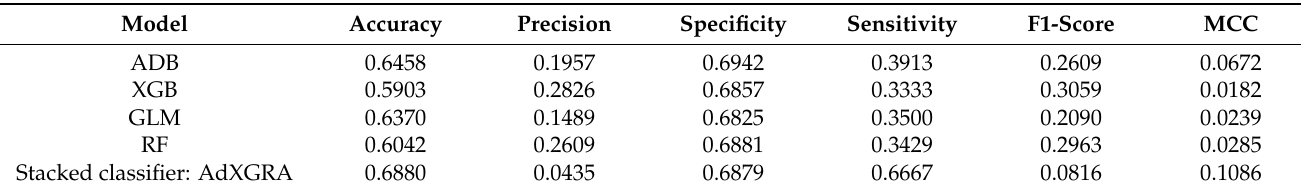
Table 5. Comparative result of model with